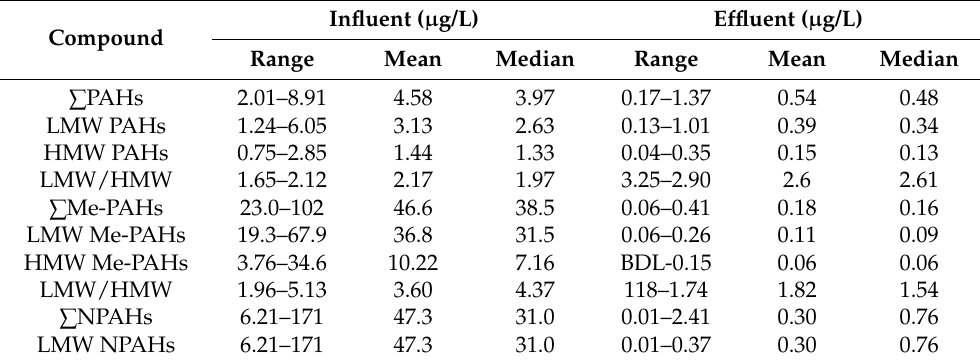
Table 1. Concentrations ( µ g/L) of ∑ 16 PAHs, ∑ 33 Me-PAHs, and ∑ 14 NPAHs from 10 wastewater treatment plants